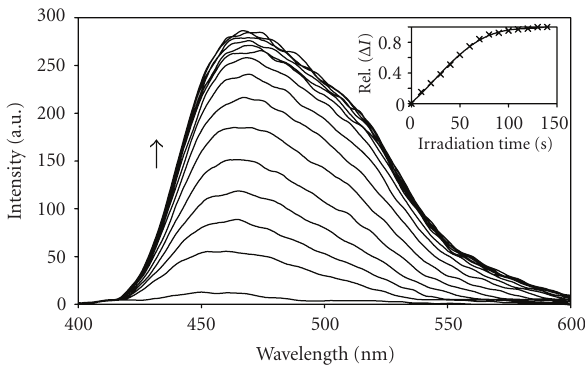
Figure 4: Recorded change in the emission spectrum of an ITS oxygen indicator film (broken line), under vacuum, upon exposure to UVA light as a function of time. The spectra illustrated were irradiated (from bottom to top) for 0 second up to 140 seconds, in 10-second intervals. The insert diagram illustrates the change in luminescence intensity of the indicator film at 470 nm as a function of irradiation time, derived from the data in the main